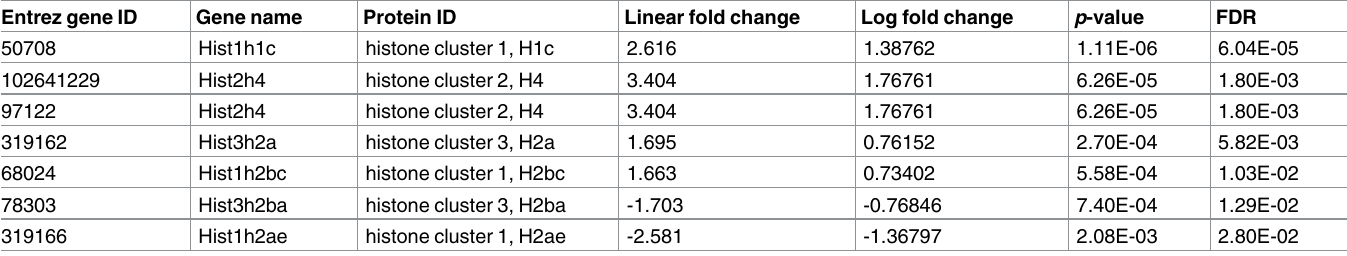
Table 2. List of histone genes with altered abundance in Cryaa -R49C-homo mouse lenses. Entrez gene